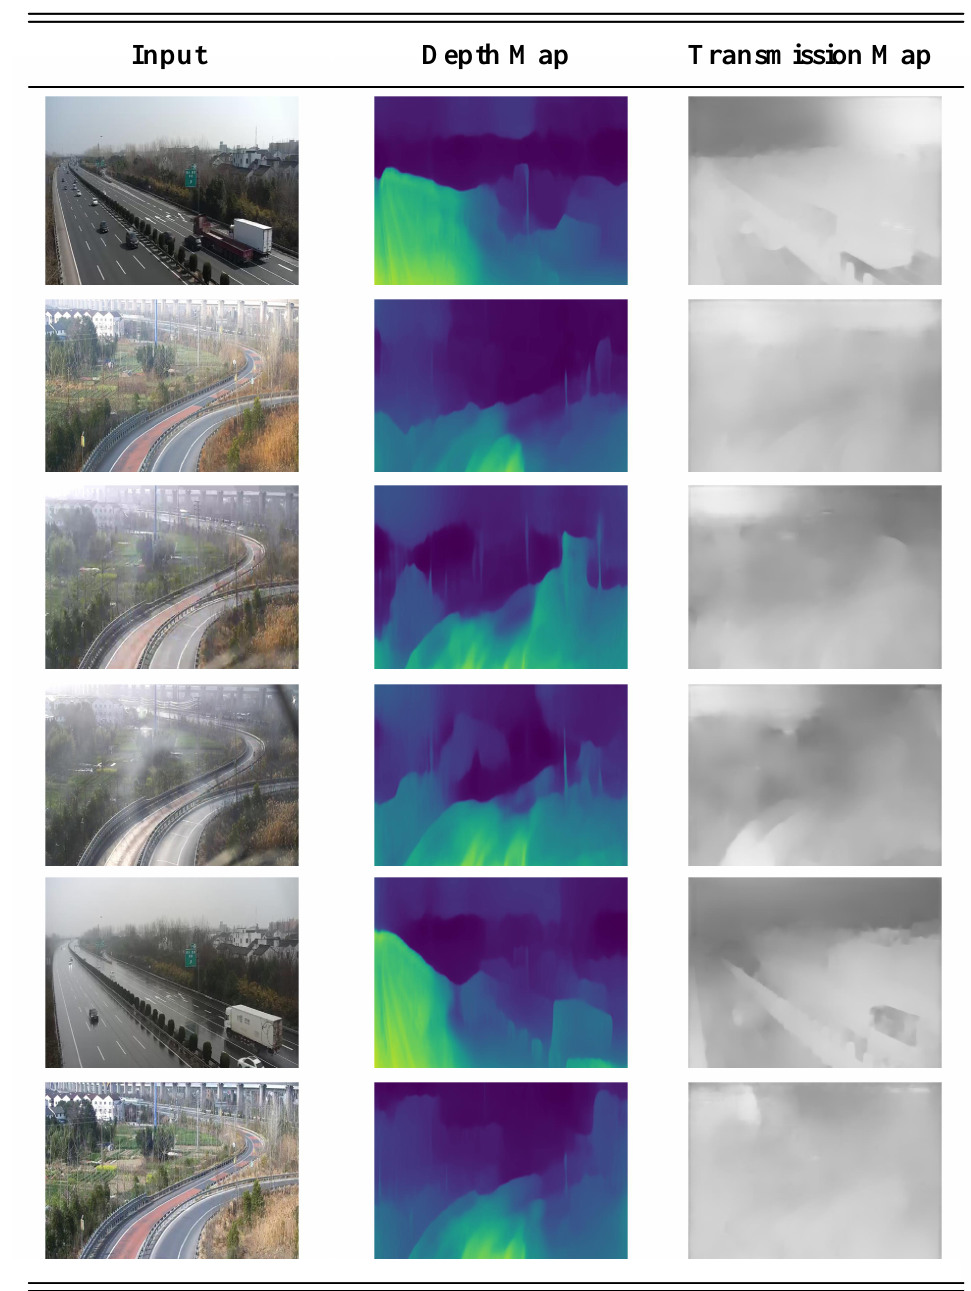
Figure 3. Visualization of the obtained depth map and transmission map for